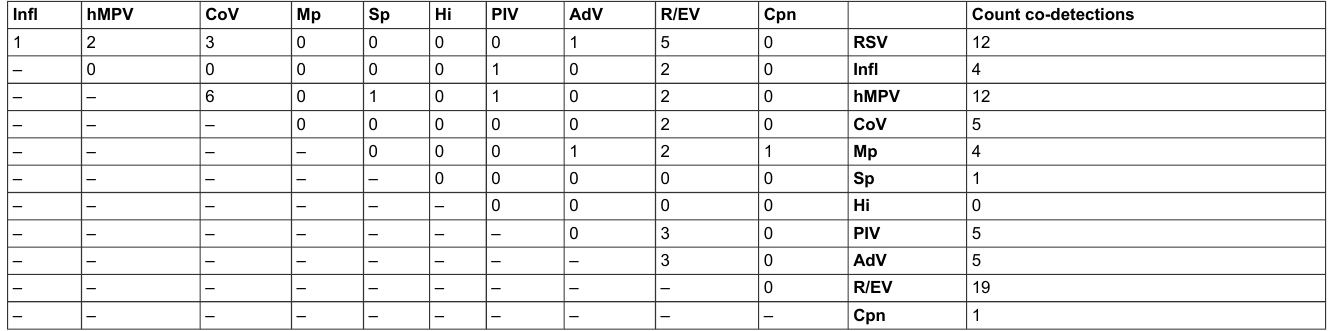
Table S1: Pathogen